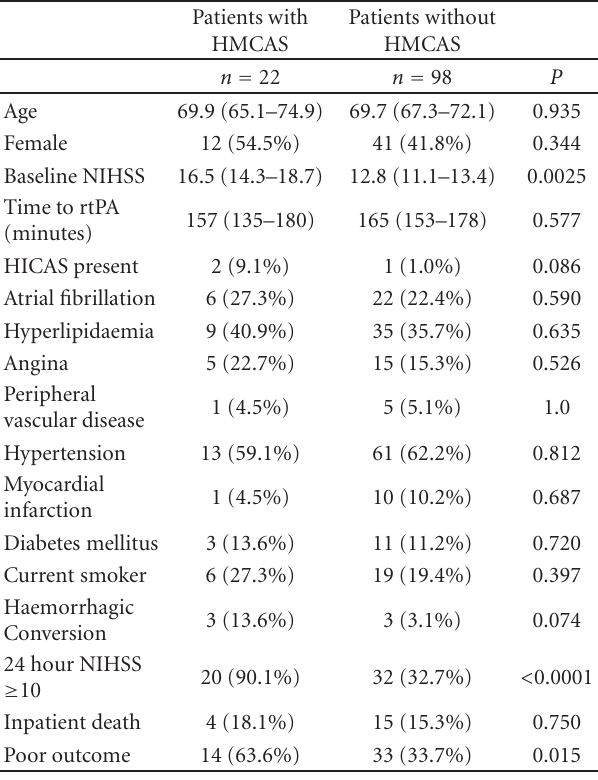
Table 2: Baseline characteristics and outcomes of patients with or without HMCAS